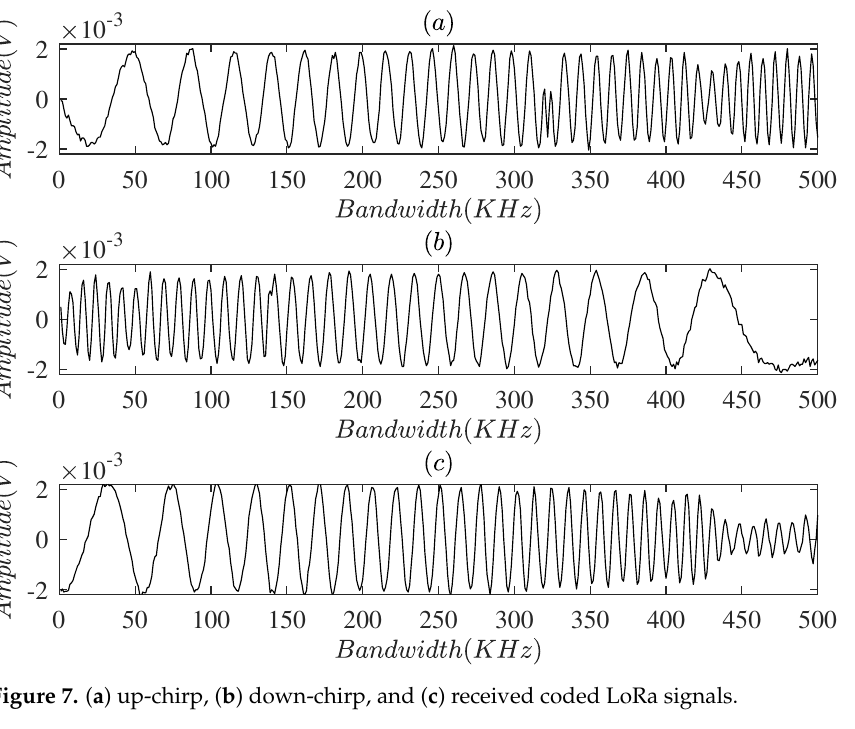
Figure 7. ( a ) up-chirp, ( b ) down-chirp, and ( c ) received coded LoRa signals.